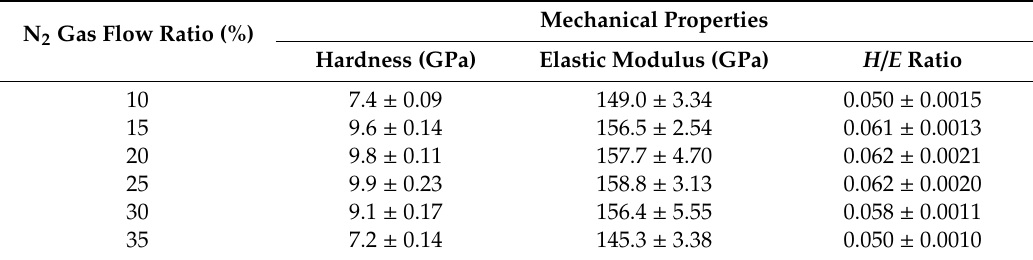
Table 2. Hardness ( H ), elastic modulus ( E ), and H / E ratios of the Mo–Si–N coatings deposited at N 2 gas flow ratios from 10% to 35%, retaining the working pressure of 10 mTorr.